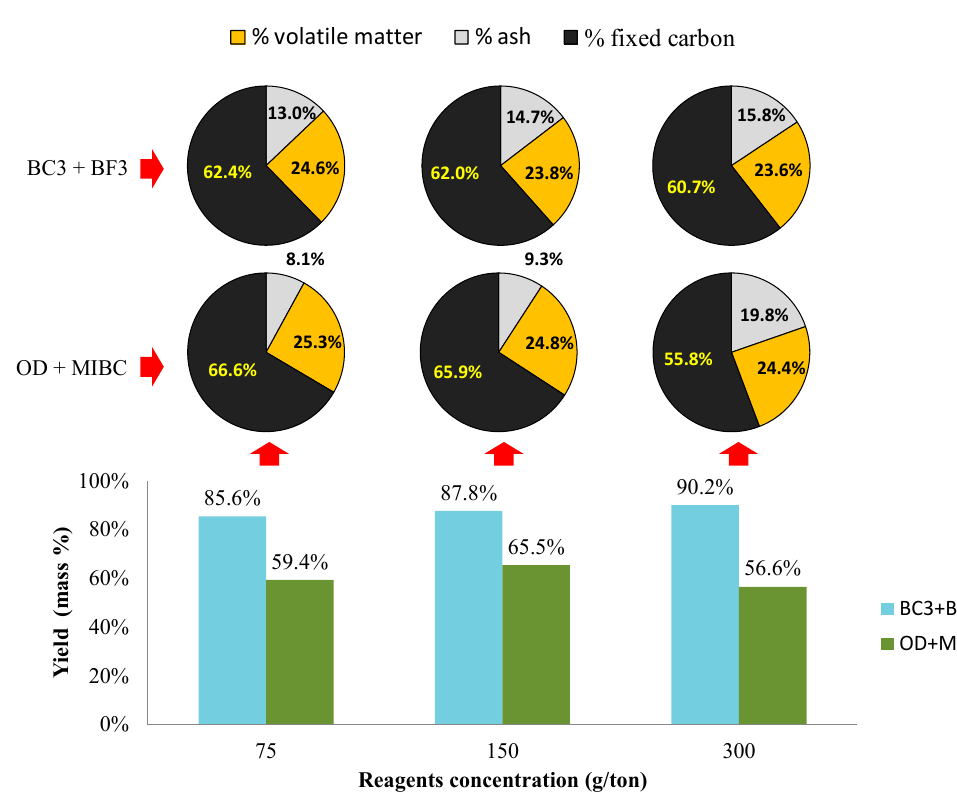
Figure 6. Flotation results (yield and froth composition) for the 20 m sample in the preliminary tests carried out.